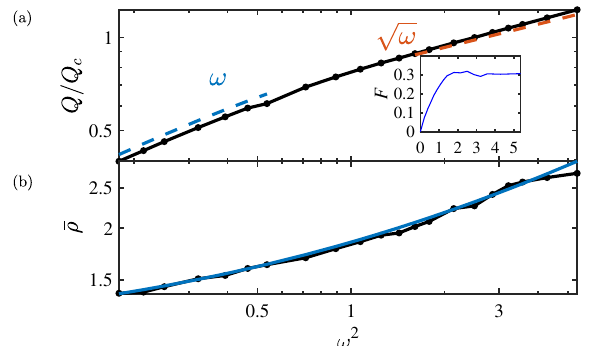
2 /ω 2 Figure 3. ( a ) Q -factor of the optimal coil as a function of ω c . The connected dots are our numerical results. The two dashed lines indicate the expected low- and intermediate-frequency scaling. Inset: loss factor F vs . ρ of the coil in units of ρ c as a function of ω 2 /ω 2 c ω 2 /ω 2 c . ( b ) Mean radius ¯